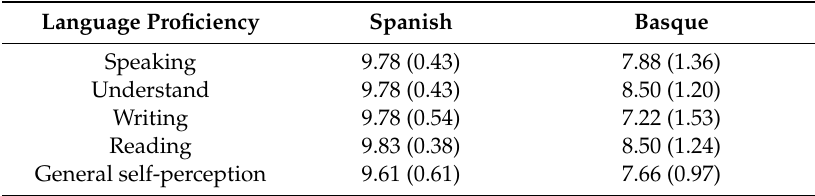
Table 1. Experiment 1: Mean levels of first language (L1; Spanish) and second language (L2; Basque) language proficiency derived from participants’ self-ratings (range: 0 = none, 10 = native-like). Standard deviations are provided within